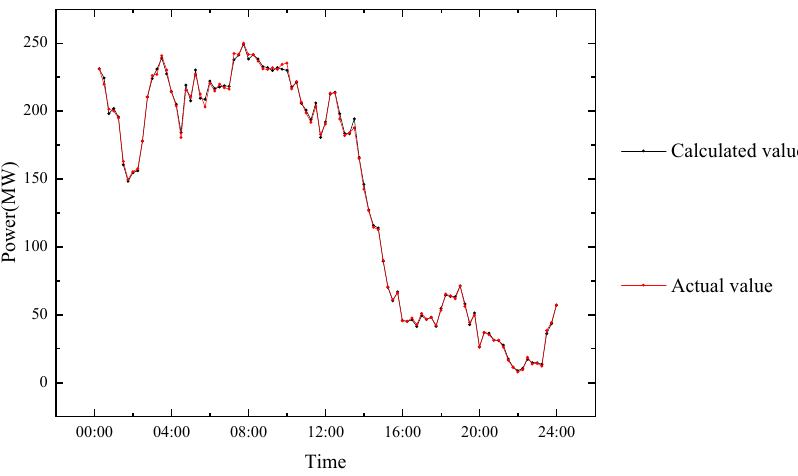
Figure 14. Result of cable loss calculation.